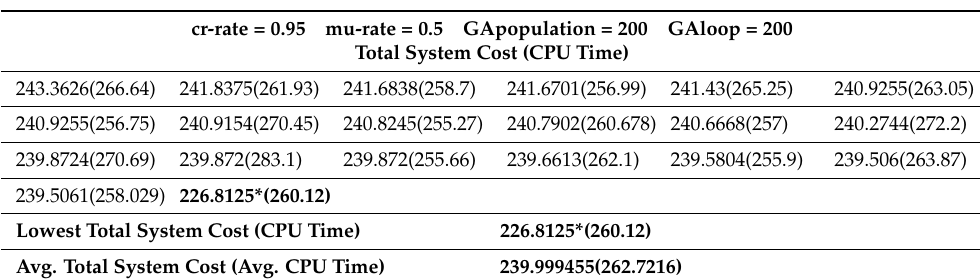
Table 33. The total system costs of 20 simulation runs obtained by MRAH–MGA for the n -stage q /2- out-of- q system.